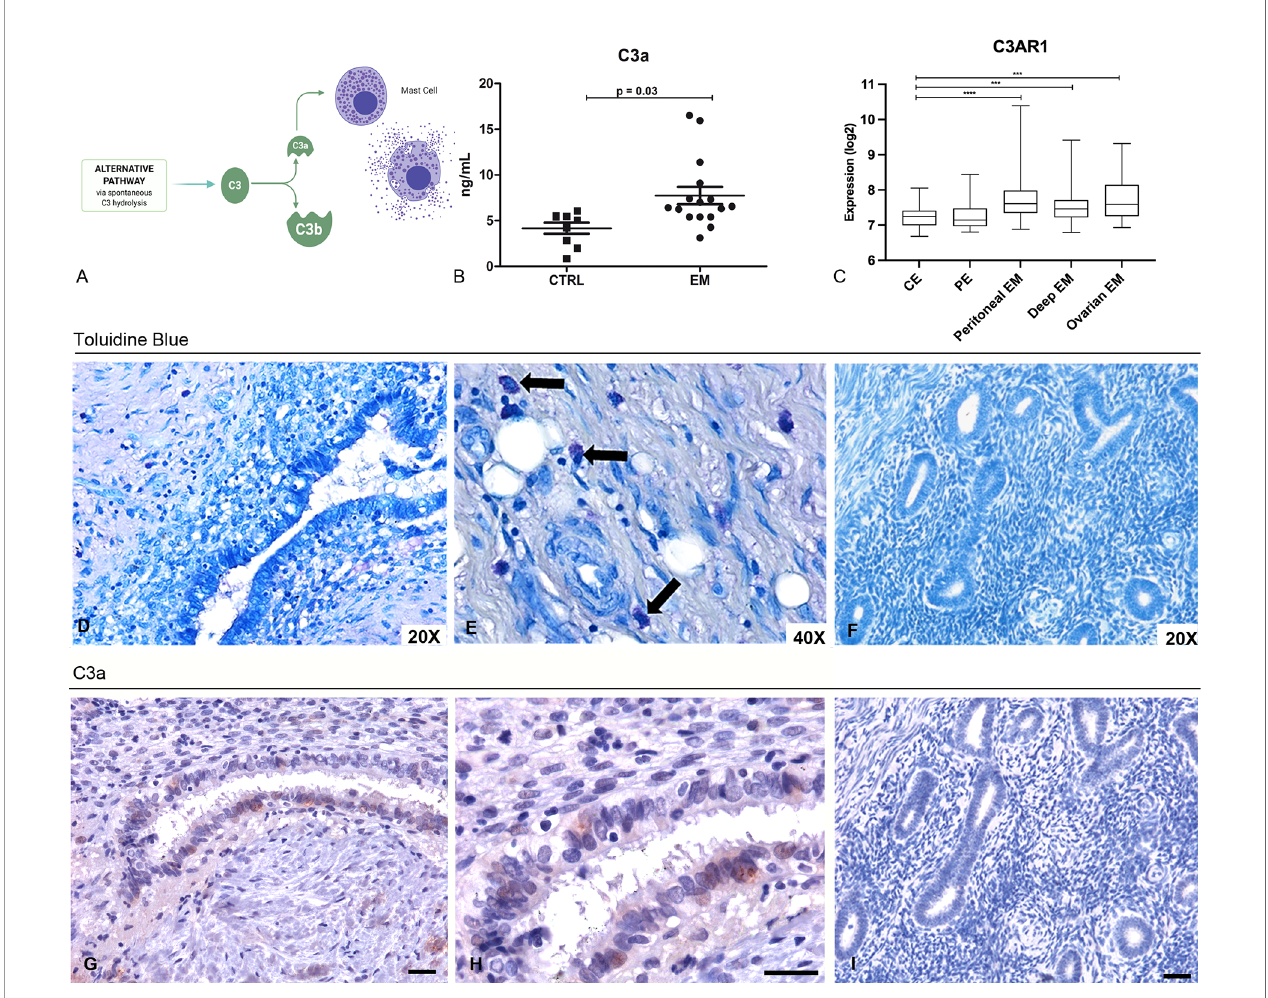
FIGURE 3 | Peritoneal Fluids (PFs) derived from EM patients contained elevated levels of C3a that likely acts on MCs in the EM tissue. (A) Graphical representation of the C3 cleavage and C3a formation. (B) C3a ELISA evaluation of PFs isolated from EM patients (n = 16) compared to control patient group (n = 8). (C) Histogram representing C3AR1 mRNA expression in control endometrium (CE), patient endometrium (PE) and in different EM lesions (peritoneal, deep and ovarian EM). GEP analysis, based on data extracted from GEO (GSE141549), highlighted a signi fi cantly higher expression of C3AR1 in EM lesions as compared to CE. ***p < 0.001, ****p < 0.0001 (Mann-Whitney U Test). (D, E) Toluidine blue staining of human EM tissue sections for the evaluation of MCs presence. Black arrows indicate MCs. (F) Toluidine blue staining of secretive uterine endometrium revealed the absence of MCs. (G, H) Immunohistochemical analysis of C3a in EM tissue sections. AEC (red) chromogen was used to visualize the binding of anti-human C3a antibodies. Nuclei were counterstained blue with Harris Hematoxylin; scale bars, 50 m m. (I) Immunoistochemical analysis of C3a in secretive uterine endometrium revealed the absence of